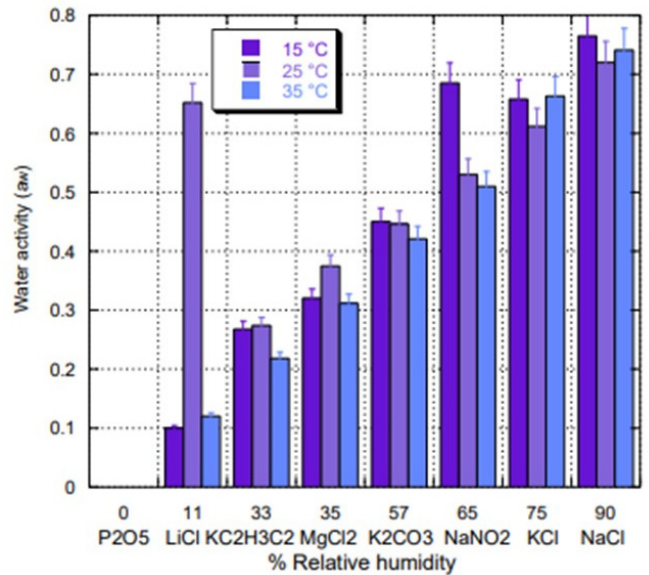
Figure 9. a w of biofilm of kefir.